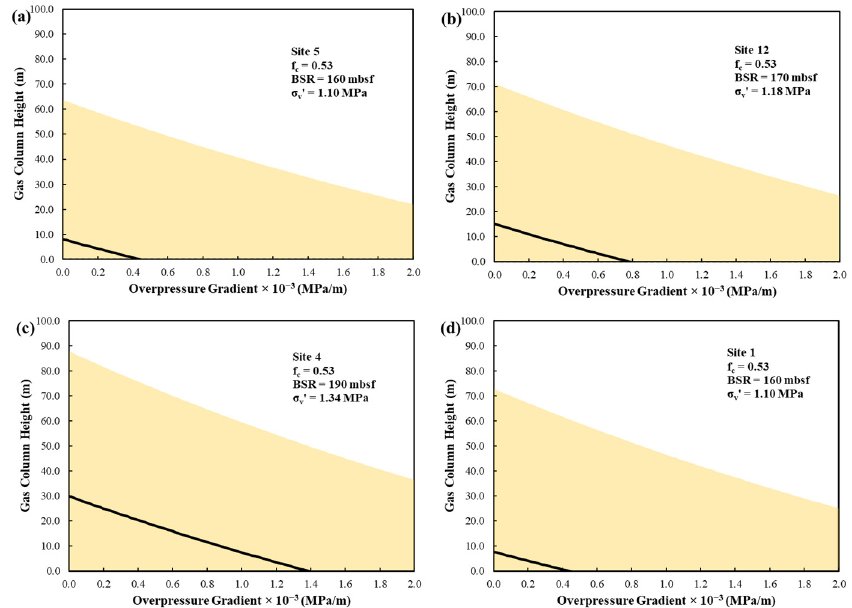
Figure 12. The gas column height required to open fractures for the 4 sites, for varying overpressure gradients ( dP */ dz ). The sites are shown from west to east. Site 5 ( a ) is the westernmost, followed by Site 12 ( b ), Site 4 ( c ) and Site 1 ( d ). The black curves show the median prediction of gas column height required to open fractures for a given overpressure gradient and the shaded region is the uncertainty ( ± 1 SD).